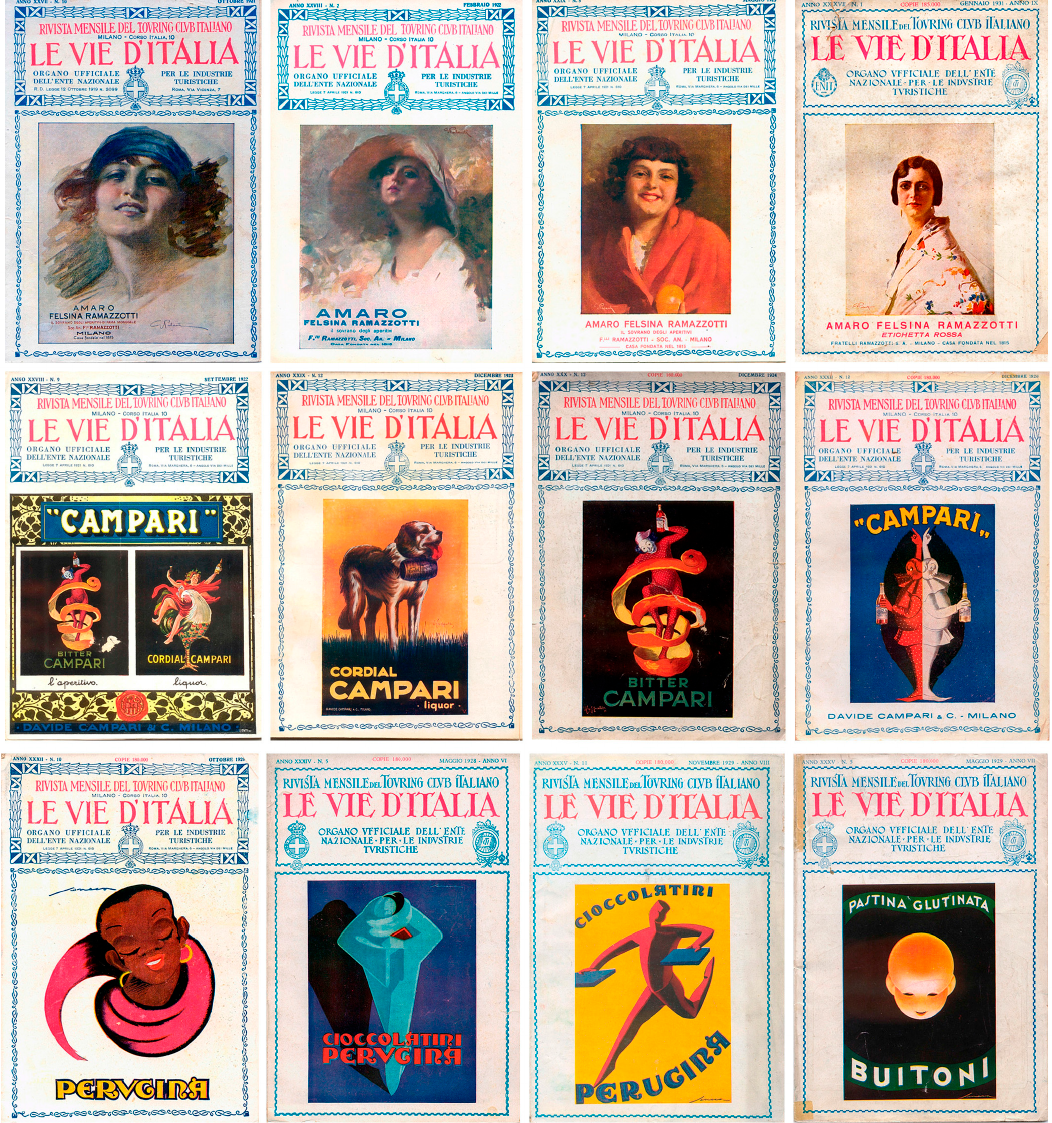
Figure 2. The covers/manifestos of Le Vie d’Italia . Top: Giuseppe Palanti (1881–1946) for Amaro Felsina Ramazzotti (October 1921, February 1922, May 1923, January 1931). At the centre: Leonetto Cappiello (1875–1942) for Campari (September 1922, December 1923, December 1924, December 1926). Bottom: Federico Seneca (1891–1976) for Perugina (October 1926, May 1928, November 1929) and Pasta Glutinata Buitoni (May